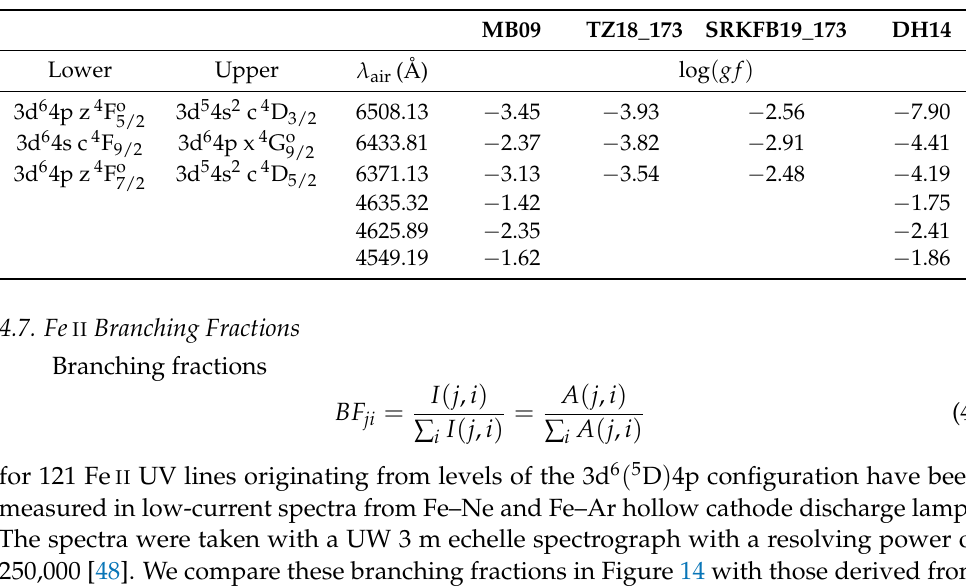
Table 15. Problematic transitions in the gf -value comparison of MB09 [47] with atom_TZ18_173, atom_SRKFB19_173, and DH14 [43] showing large discrepancies or unidentified